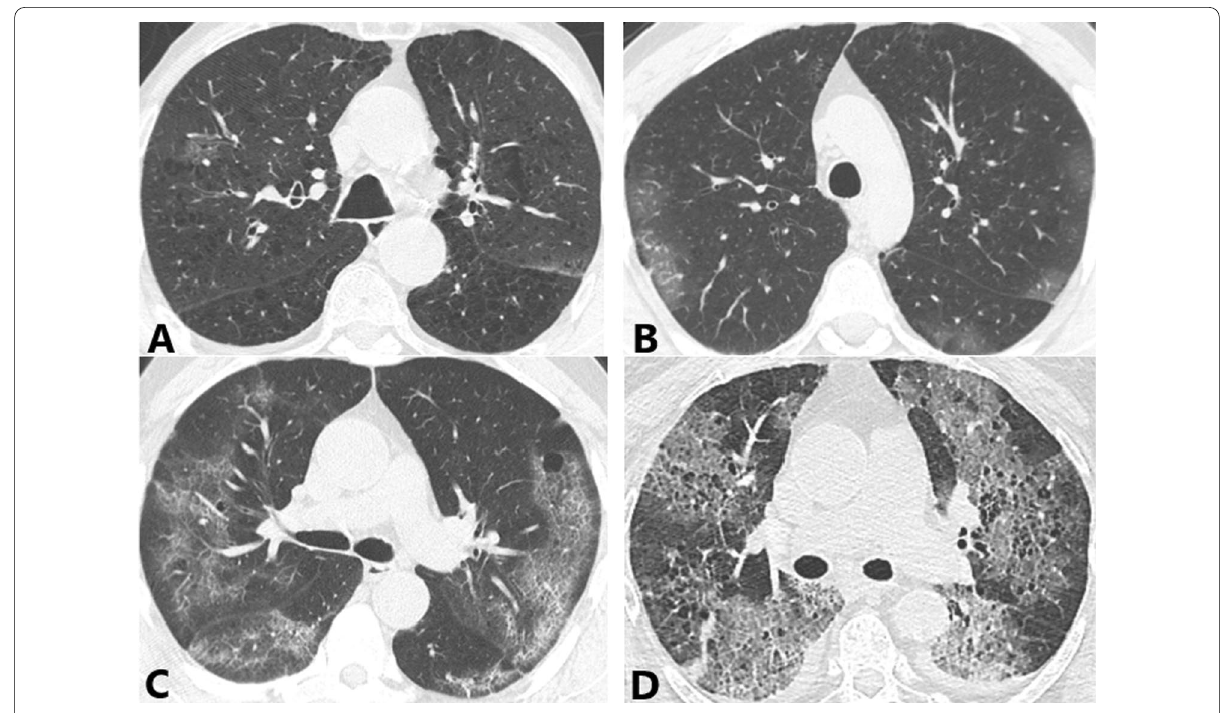
Fig. 4 Illustration of total lung scores of patients in the COPD group shown on axial CT images. A CT 1 (mild), < 25% involvement. B CT 2 (moderate), 25–50% involvement. C CT 3 (medium-to-severe), 50–75% involvement. D CT 4 (severe), > 75% involvement. COPD—chronic obstructive pulmonary disease; CT—computed tomography Table 4 Correlative analysis of hypoxia, in-hospital mortality and CT-based severity